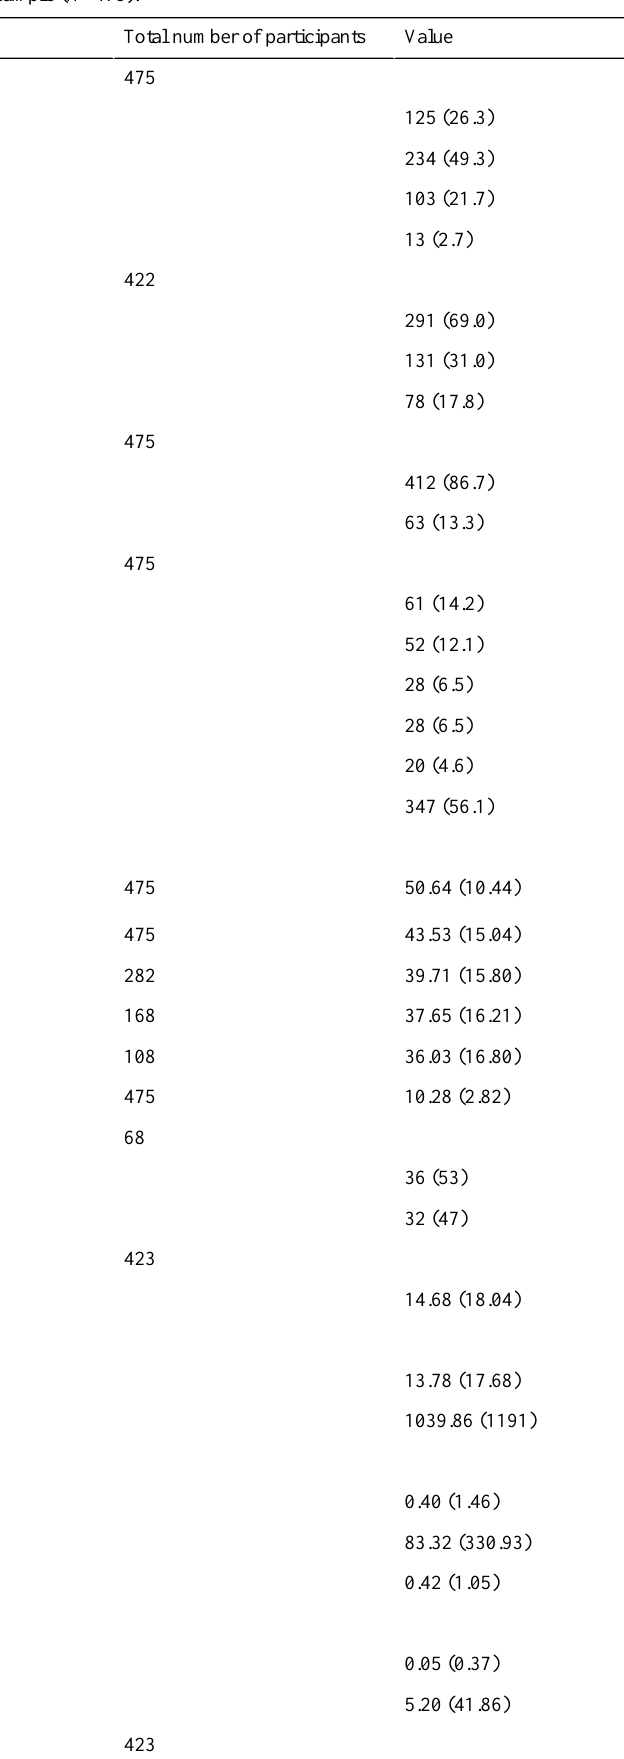
Table 1. Demographic, clinical, and treatment characteristics for full sample